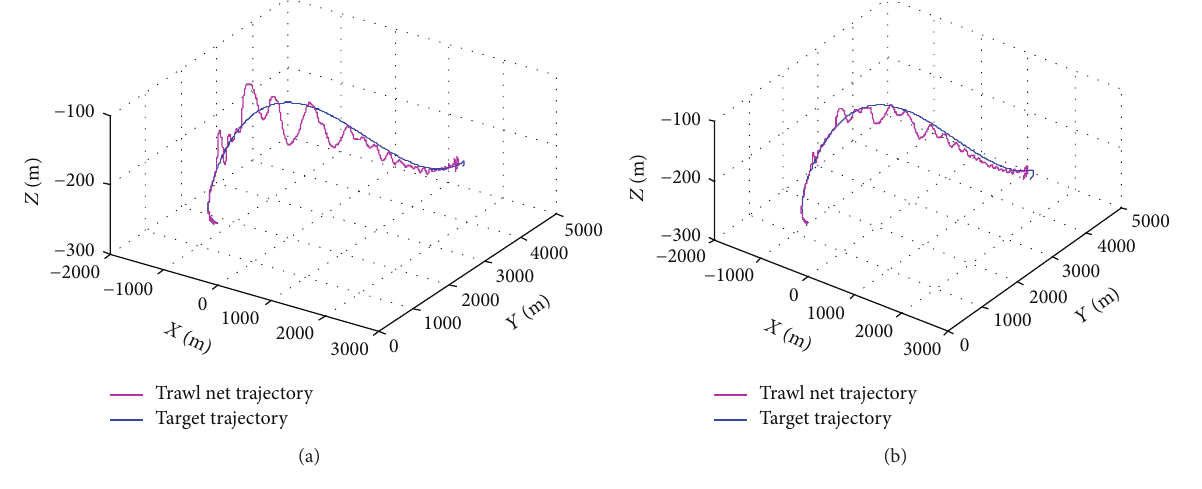
Figure 11: Trawl system tracking trajectories with disturbing